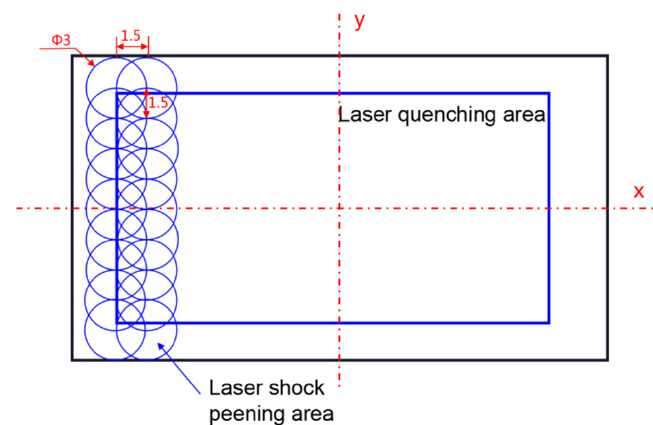
Table 2. Control group design of Cr12MoV laser quenching–shock peening composite strengthen- ing experiment. Samples